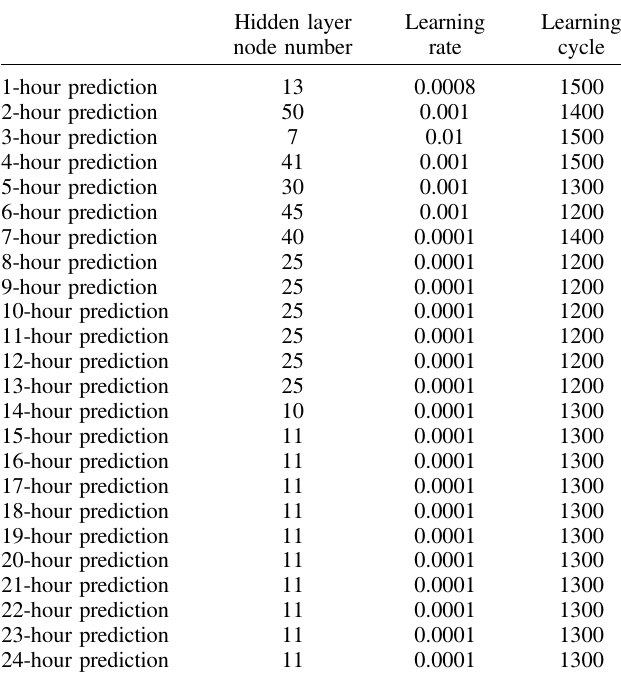
Table 2. Optimized hyperparameters of ANN models Hidden layer node number